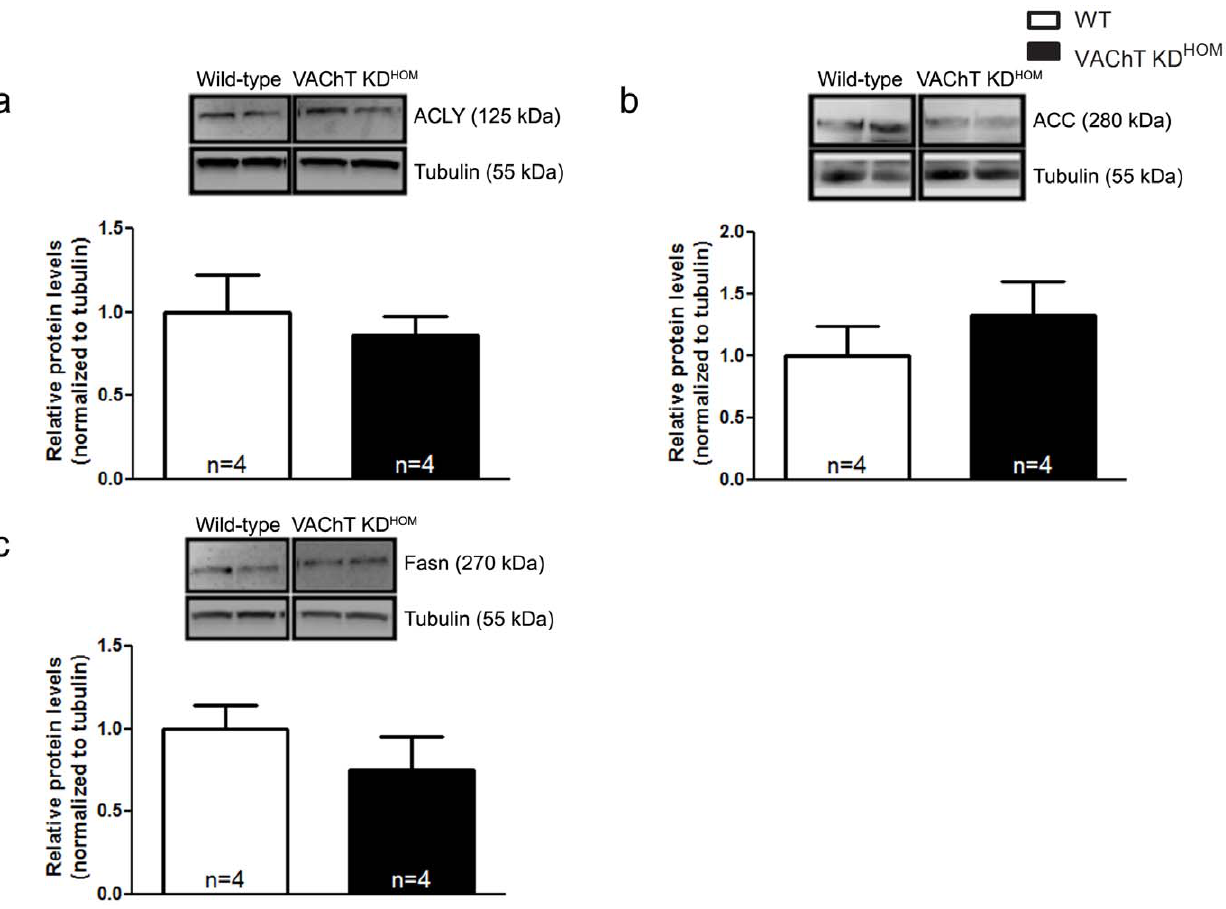
Figure 5. There are no alterations in the protein levels of enzymes involved in lipid biosynthesis. Immunoblotting analysis of ATP citrate lyase (ACLY, panel a ), Acetyl-CoA carboxylase (ACC; panel b ) and fatty acid synthase (FAS; panel c ) revealed no differences in the protein levels of these enzymes in VAChT KD HOM mice. Data represent the mean 6 SEM, with n indicated within bars. *p , 0.05 versus wild-type mice.